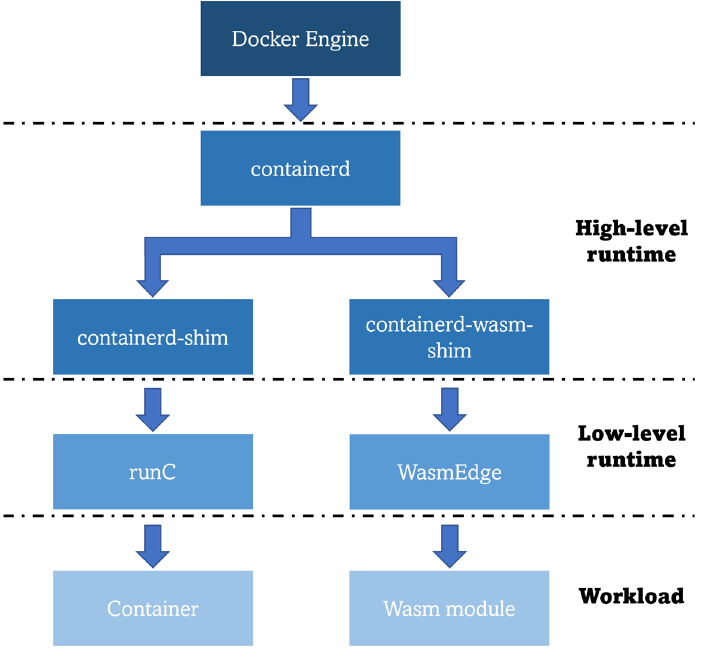
Figure 7. Docker Engine architecture for running Wasm workloads [110].